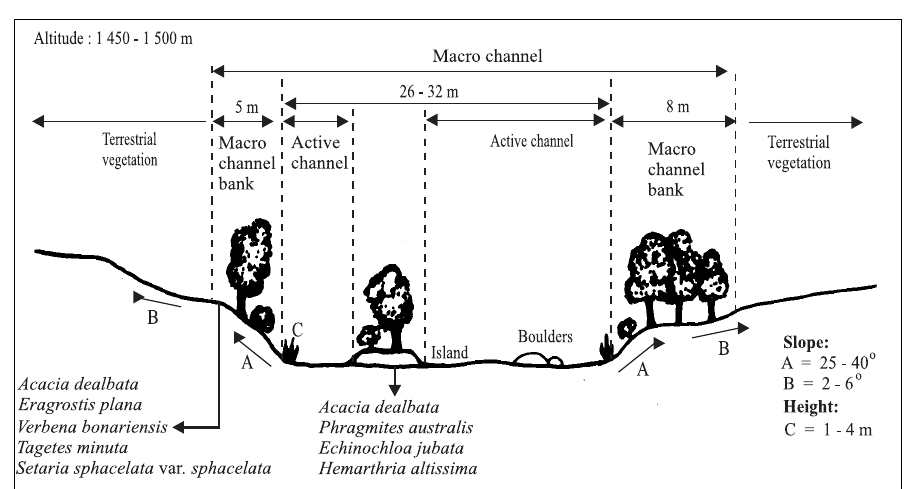
Fig. 10. River profile of the Echinochloa crus-galli-Paspalum distichum grassland.